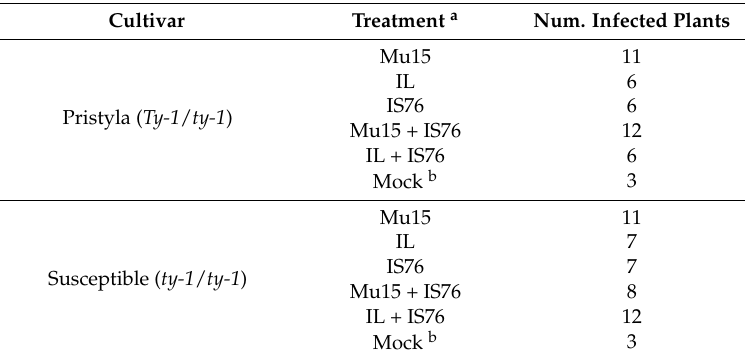
Table 3. Design of the in planta fitness